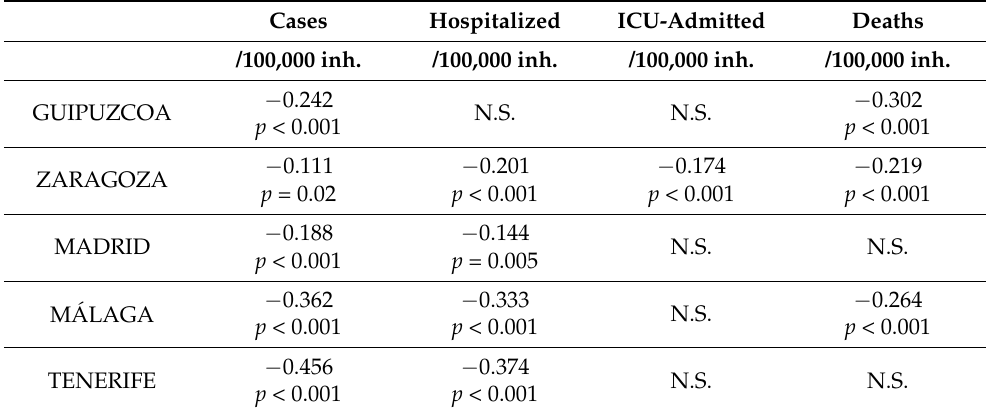
Table 2. Correlations between UVI and COVID-19 incidence rate, hospitalized cases, ICU-admitted cases, and deaths per 100,000 inhabitants. Cases Hospitalized ICU-Admitted Deaths /100,000 inh. /100,000